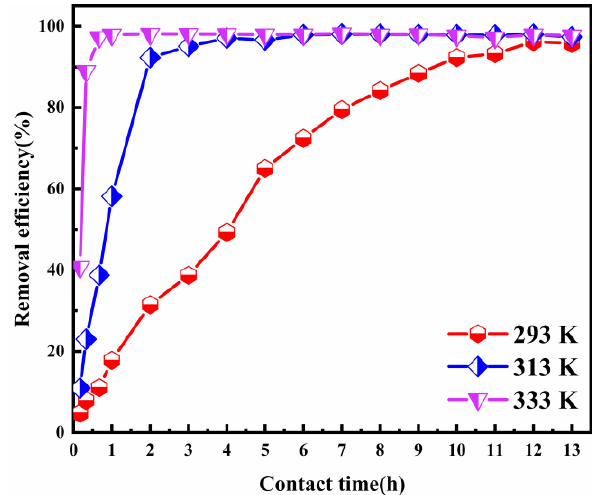
Figure 6. Cl − removal efficiency as a function of the adsorbent dose (ion ratio Mg:Al = 6:1; Cl − initial concentration: 2000 mg L − 1 ; adsorbent dosage: 2 g; contact time: 13 h).